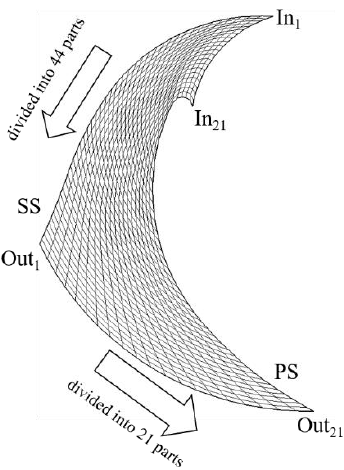
Figure 11. Grid partition diagram.